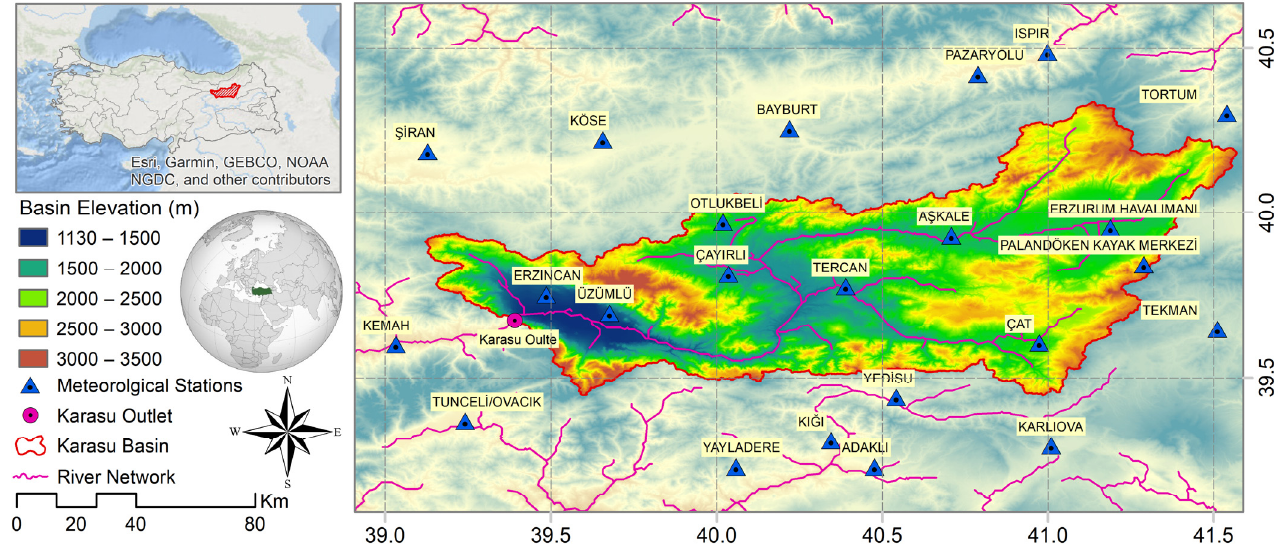
Figure 1. Geographical location of the study area (Karasu basin), basin elevation (m) ranges, and distribution of hydrometeorological stations.